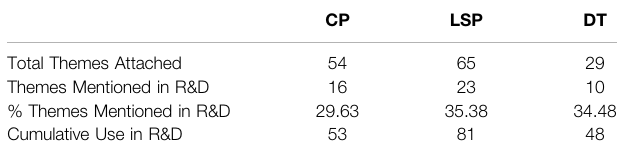
TABLE 6 | IIRD Themes mentioned during RD discussion as percentage of themes generated from fi rst